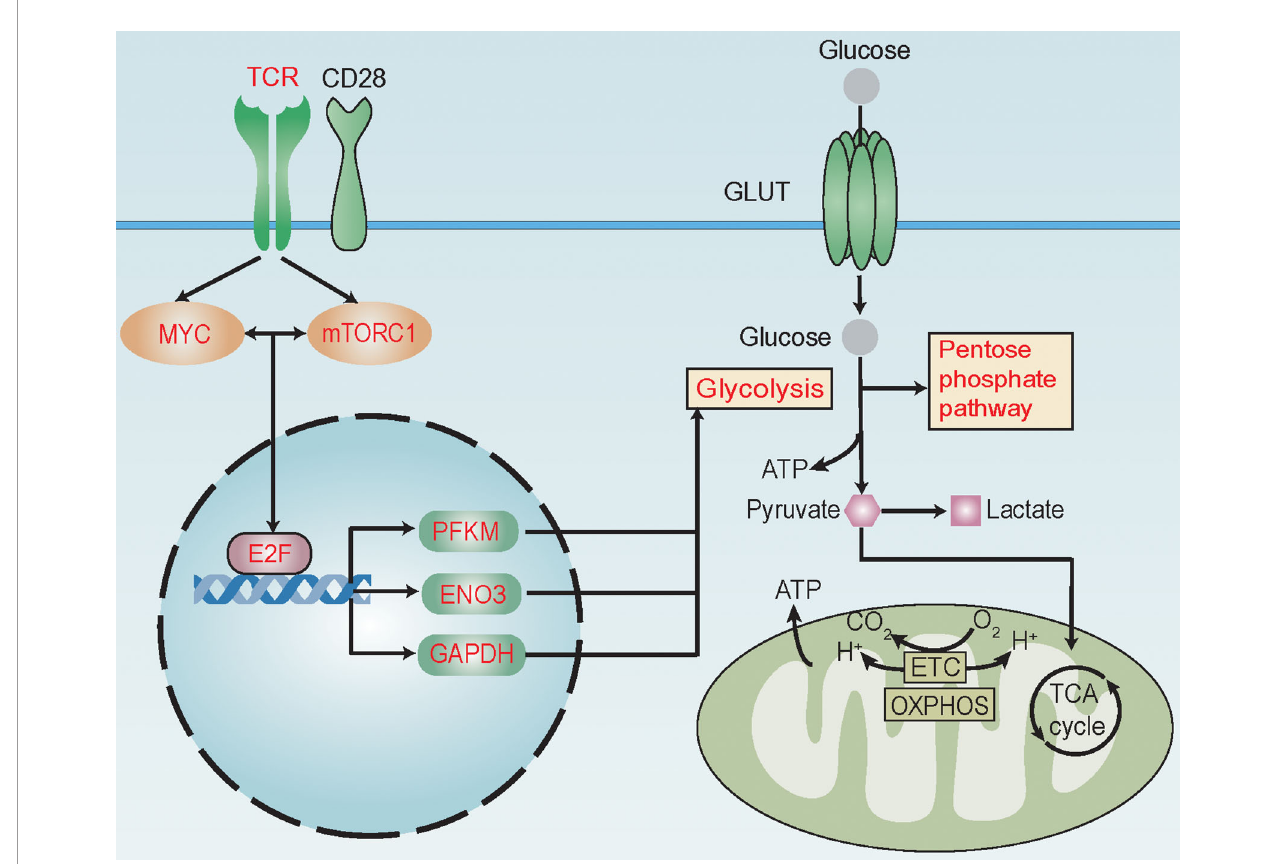
FIGURE 6 | Reprogramming of glucose metabolism in T cells during acute graft-versus-host disease (aGvHD) pathogenesis. MYC and mTORC1 signaling pathways are known to be activated by T-cell receptor (TCR) and co-stimulating molecular CD28 during antigen recognition to promote the transcriptional activity of E2F family transcription factors (TFs). During aGvHD pathogenesis, we found glycolysis and its related pathways, such as pentose phosphate pathway, to be enriched in alloreactive T cells. TCR,mTORC1, MYCsignaling pathways and E2F6 might be “ master regulators ” of glycolyticactivity.Expressionsof glycolyticgenes, such as PFKP , ENO3 , and GAPDH were shownto beelevatedand correlated with activities of TCR, MYC, and mTORC1 signaling and E2Ffamily. E2F6was predicted as a TF to regulate the expression of PFKP , ENO3 , and GAPDH. High expression ofglycolyticgenes PFKP , ENO3 , and GAPDH inT cells can predict aGvHD development. Thus, we assumed that TCR might interactwith MYC andmTORC1 to promote E2F expression,further increasing theexpression of PFKP , ENO3 , and GAPDH to activate glycolysisand its relatedpathwaysin alloreactive T cellsduring aGvHD development. These changes inglucose metabolism might promote T-cell activation through supplying energy and precursorsfor anabolism. Red text indicates activated signalingpathways, TFs, glycolytic genes, and glycolysis-related